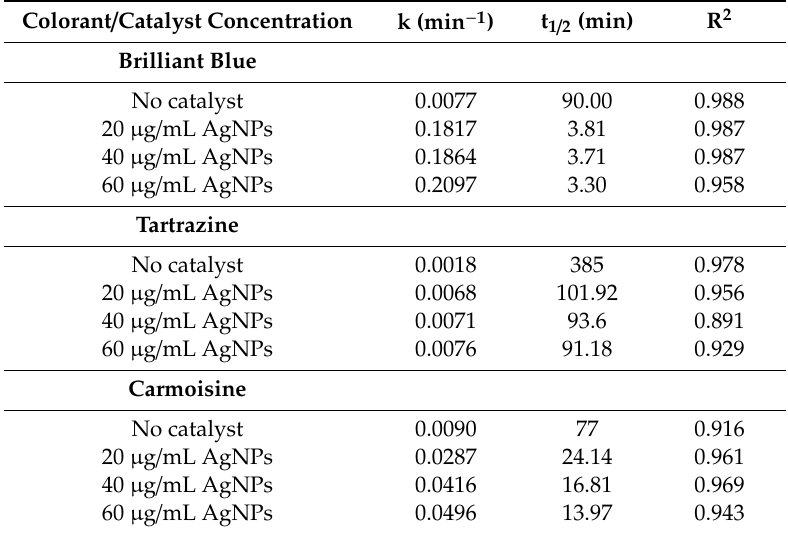
Table 1. Kinetic parameters of degradation reactions of organic